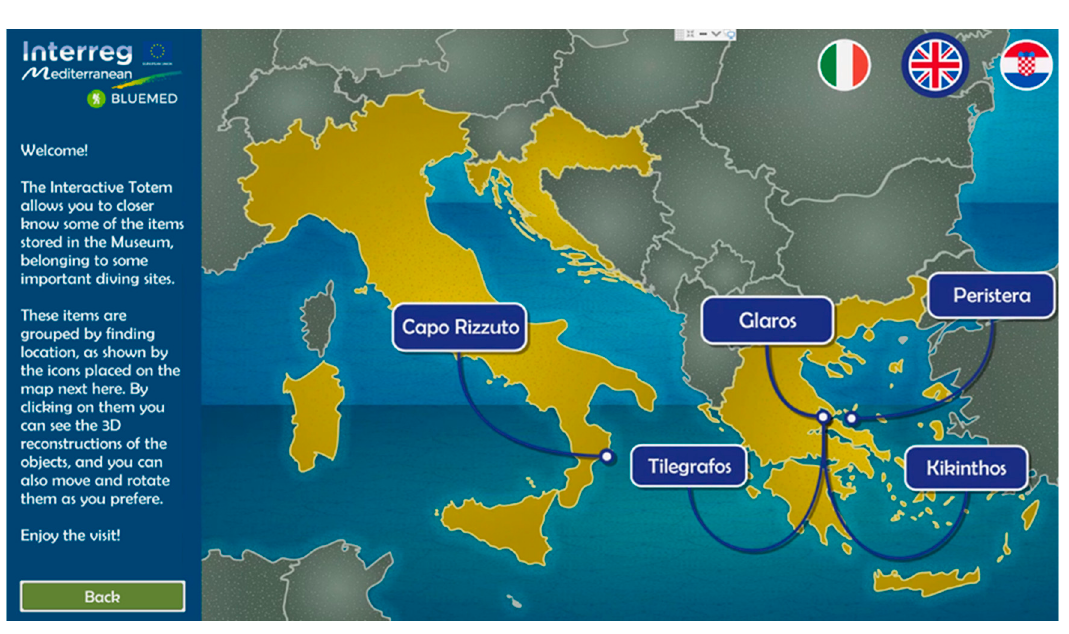
Figure 4. First screen of the BLUEMED “Virtual Museum”.